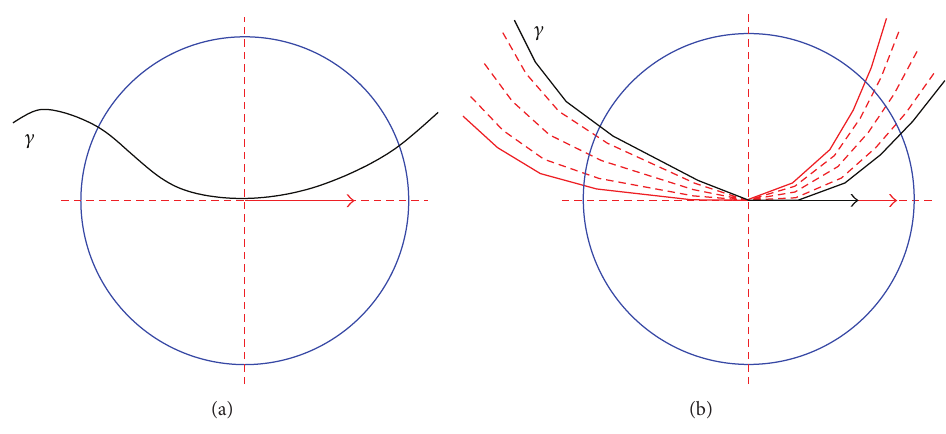
Figure 2: (a) Tangentially and (b) tangent-cone